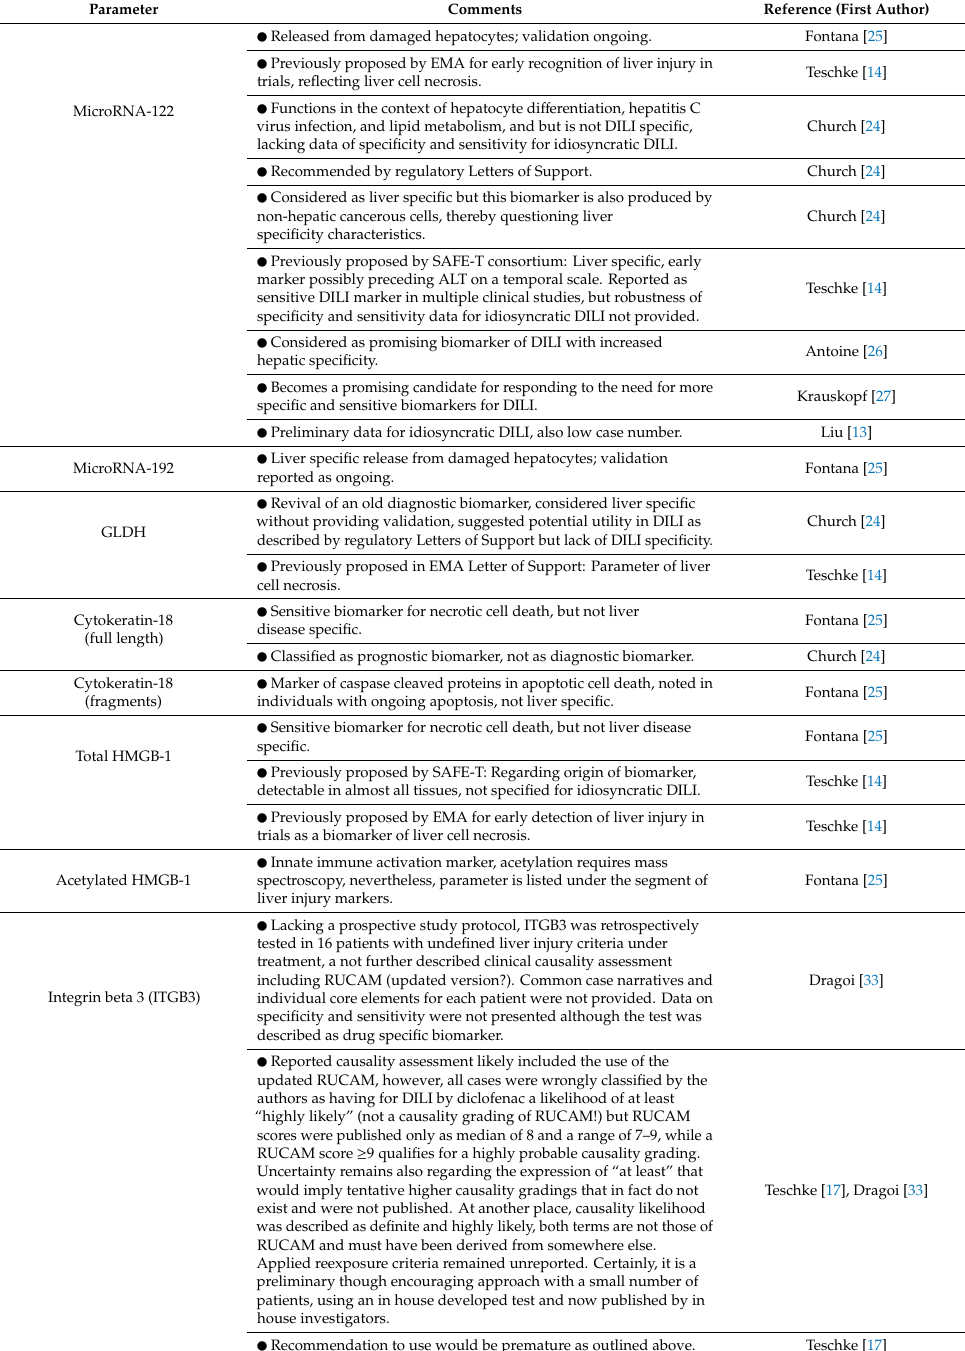
Table 1. Selected potential diagnostic biomarkers of idiosyncratic liver injury that have now mostly been retracted by